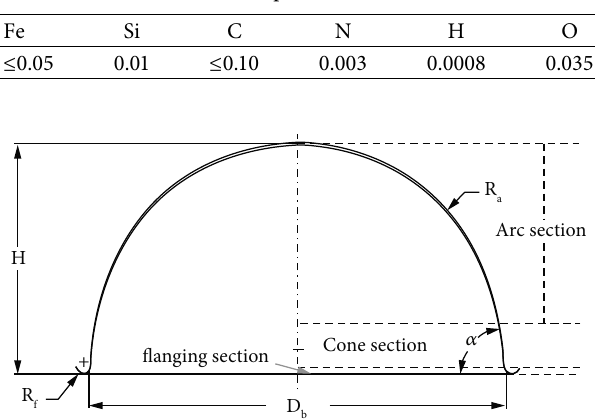
Table 1: Chemical composition of TA1ELI (wt (%)).